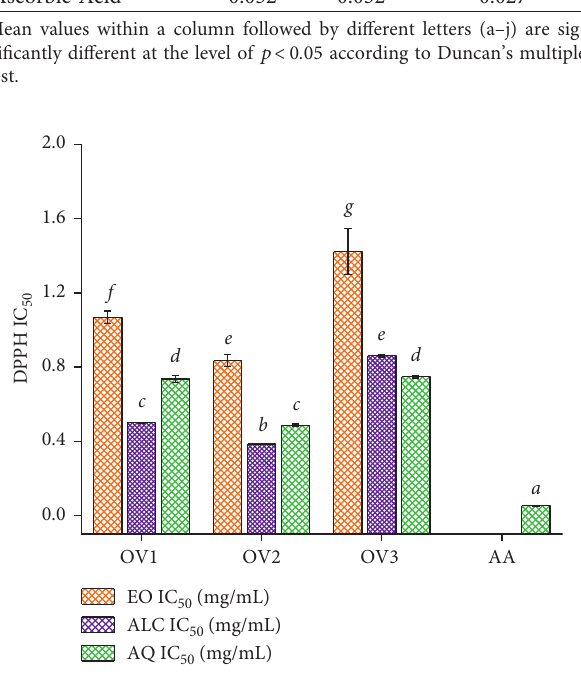
Figure 5: IC 50 plot of DPPH radical scavenging activity of essential oil (EO) and alcoholic (ALC) and aqueous (AQ) extracts of Origanum vulgare from different locations, i.e., Auli (OV1), Pithoragarh (OV2), and Haldwani (OV3).